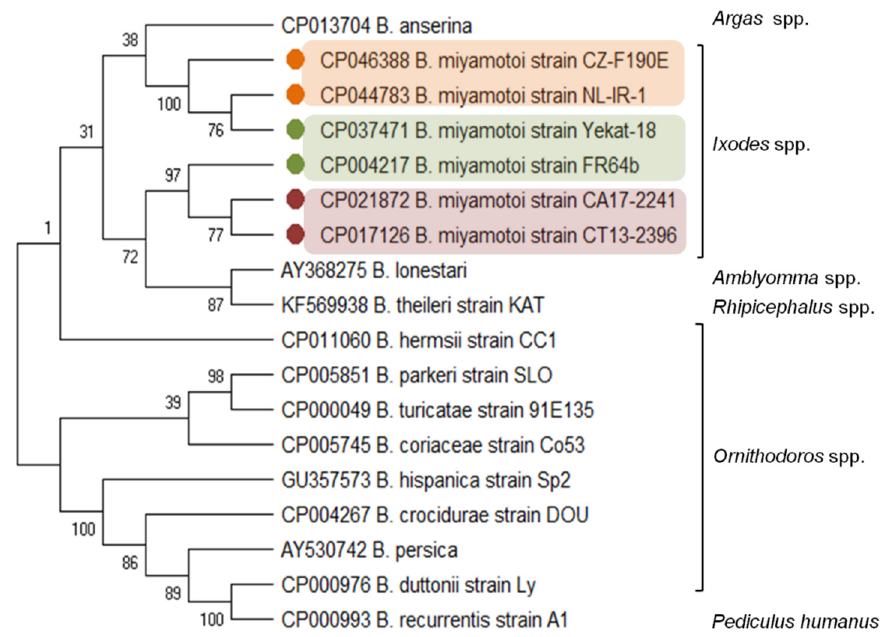
Figure 1. Molecular relationships between B. miyamotoi and other RF Borrelia species based on the sequences of the glpQ gene selected from GenBank. The consensus tree constructed using the neighbor-joining method and the maximum composite likelihood as the distance method; numbers at the tree nodes indicate bootstrap value from 1000 replicates; analyses were conducted in MEGA X [38]. Marks: orange—European type, green—Asian type, red—American type of B. miyamotoi . The genus names of the vectors were added.